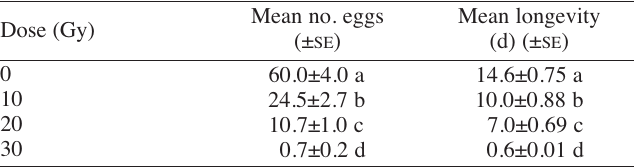
Table 1 - Effect of different doses of gamma irradiation on mean num- ber of eggs and longevity of phylloxera Mean no. eggs Mean longevity Dose (Gy) (± SE ) (d) (± SE